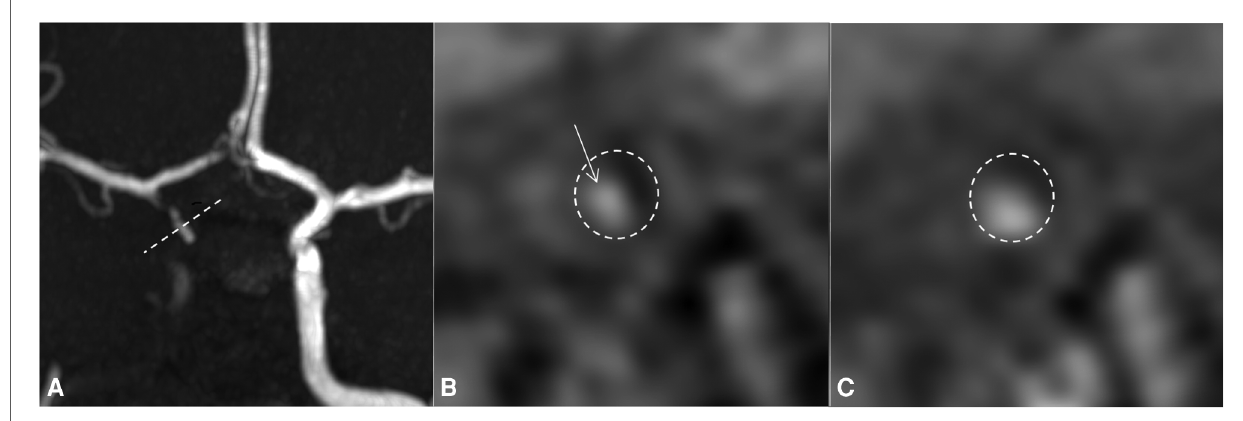
FIGURE 1 Day 4 MRI with TOF sequence ( A ) and 3D SPACE T1 imaging of the vessel wall before ( B ) and after gadolinium injection ( C ). The reconstruction of ( B ) and ( C ) images follows the dotted line on the TOF sequence (A: dotted line). For easy identi fi cation, the internal carotid artery is surrounded by a dotted circle on ( B ) and ( C ). On the TOF sequence, the right internal carotid artery is occluded and the right anterior circulation is supplied downstream by the right PComm and AComm. On vessel wall imaging, there is a spontaneous marginalized and asymmetric hyperintense signal ( B , arrow) that enhances after injection of gadolinium, without enhancement of the vessel wall itself ( C ), highly indicative of a wall hematoma due to focal intradural dissection of the right internal carotid artery. MRI, magnetic resonance imaging; PComm, posterior communicating artery; AComm, anterior communicating artery.